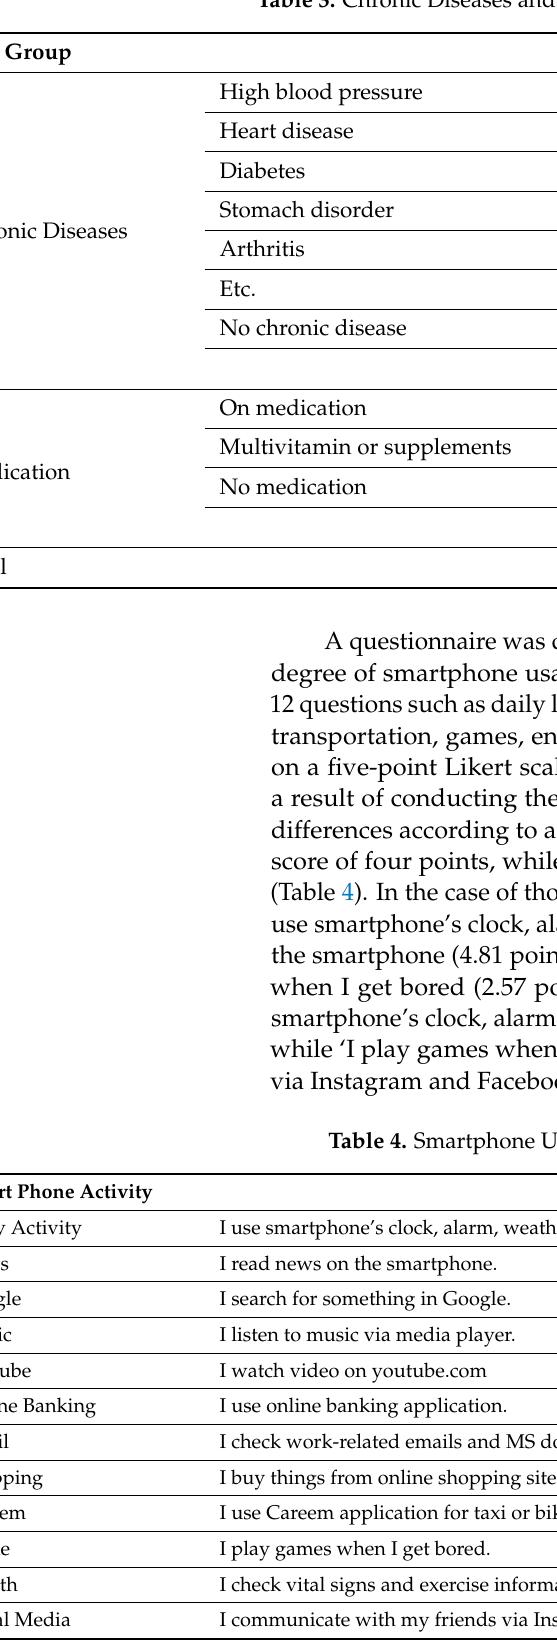
Table 3. Chronic Diseases and Medication by Age Group (* p < 0.01).